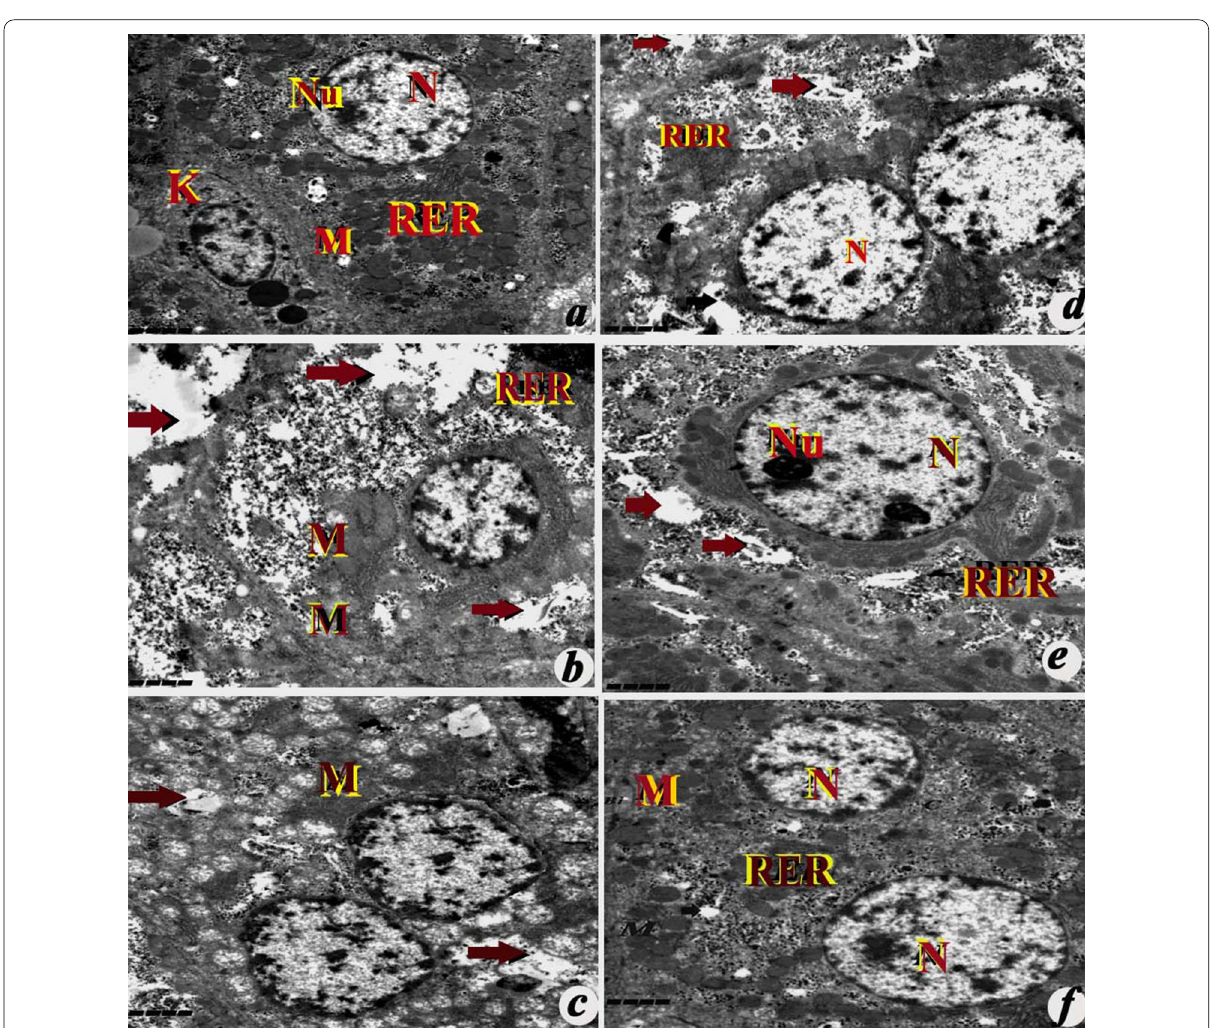
Fig. 7 Electron micrograph of a section of the liver from a control group showing normal hepatocyte structure, nucleus (N) with prominent nucleolus (Nu), numerous mitochondria (M), rough endoplasmic reticulum (RER), and Kupffer cell (K) with elongated nucleus b DMBA‑treated group demonstrating abnormal hepatocyte with several lucent and degenerated areas of the cytoplasm (black arrows) degenerated (RER), highly damaged mitochondria (M) with ill‑defined cristae. c DMBA Art‑treated group demonstrating abnormal hepatocyte with lucent and degenerated + area of the cytoplasm (black arrows) and damaged mitochondria (M). d DMBA Ech‑treated group demonstrating relatively little normal + appearance of hepatocyte with few lucent and degenerated area of the cytoplasm (black arrows) and normal rough endoplasmic reticulum (RER). e Art DMBA‑treated group demonstrating moderately normal hepatocyte with normal nucleus (N), nucleolus (Nu) and endoplasmic reticulum (RER) + with nearly normal appearance, except little degenerated areas (black arrows) f (DMBA Ech) group demonstrating hepatocyte with nearly normal + cytoplasm appearance, nucleus (N), mitochondria (M) and (RER) (Scale bar 2 =